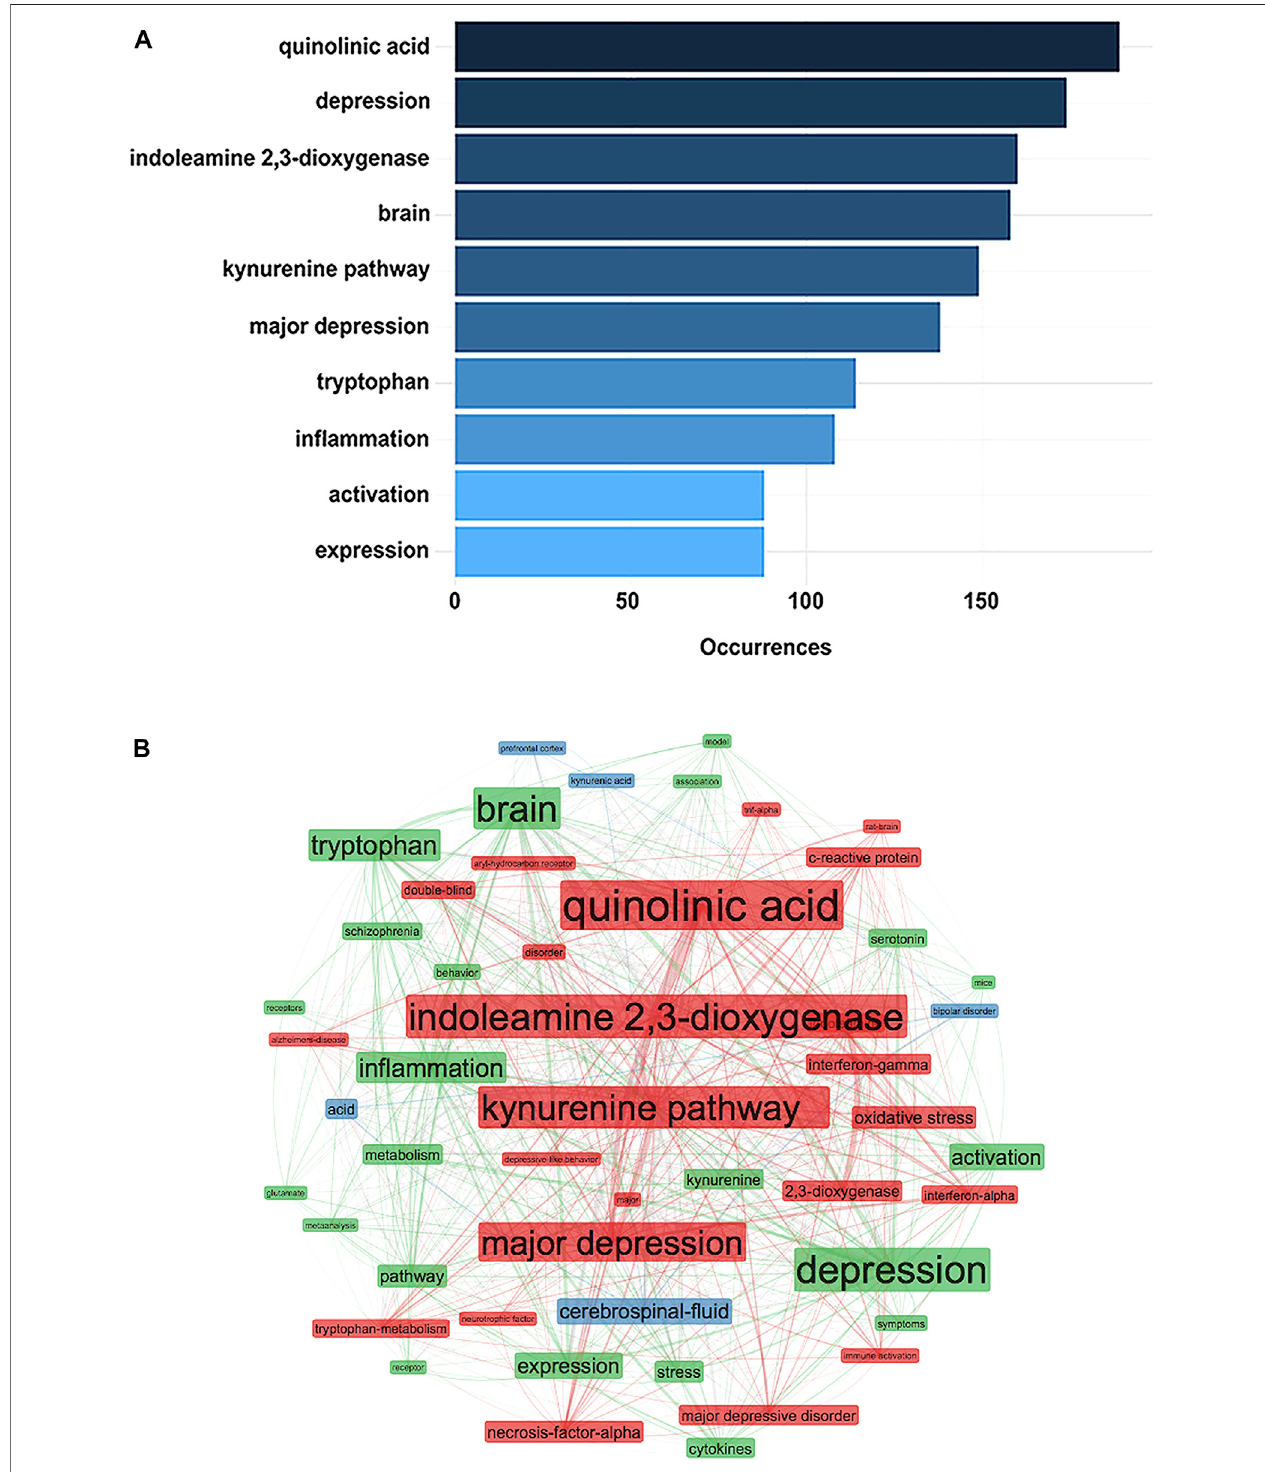
FIGURE 10 | | (A) The top ten highest frequency keywords extracted by using “ Keywords Plus ” from the WoSCC database via the biblioshiny app (B) Cluster visualization of the keyword co-occurrence network among the 50 main keywords via the biblioshiny app, presented in a sphere network layout.